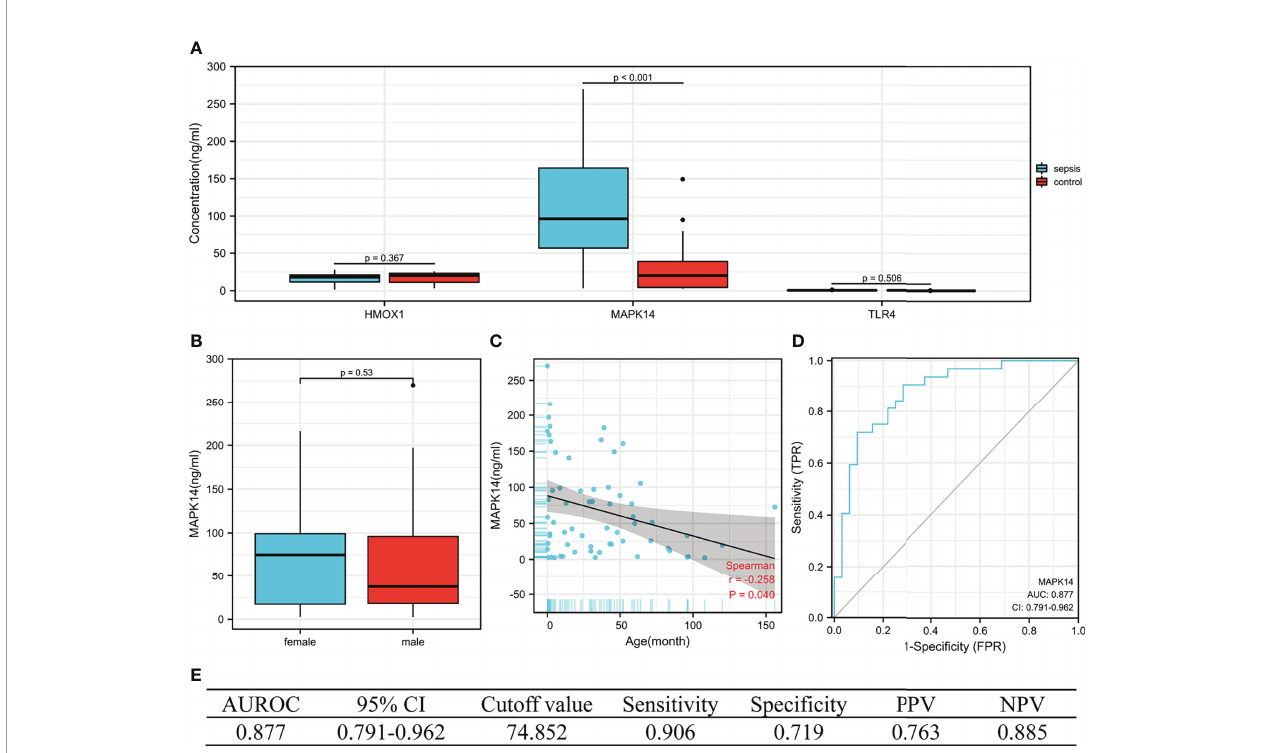
FIGURE 8 | The performance of hub genes in the validation cohort. (A) Concentration of three hub proteins in serum. (B) Concentration of MAPK14 in different genders. (C) Correlation between MAPK14 and age. (D) ROC curve of serum MAPK14 protein diagnosis of sepsis. (E) Diagnostic value of serum MAPK14 for differentiating between sepsis and control patients. PPV, positive predictive value; NPV, negative predictive value; AUROC, area under the receiver operating characteristics curve; CI, con fi dence